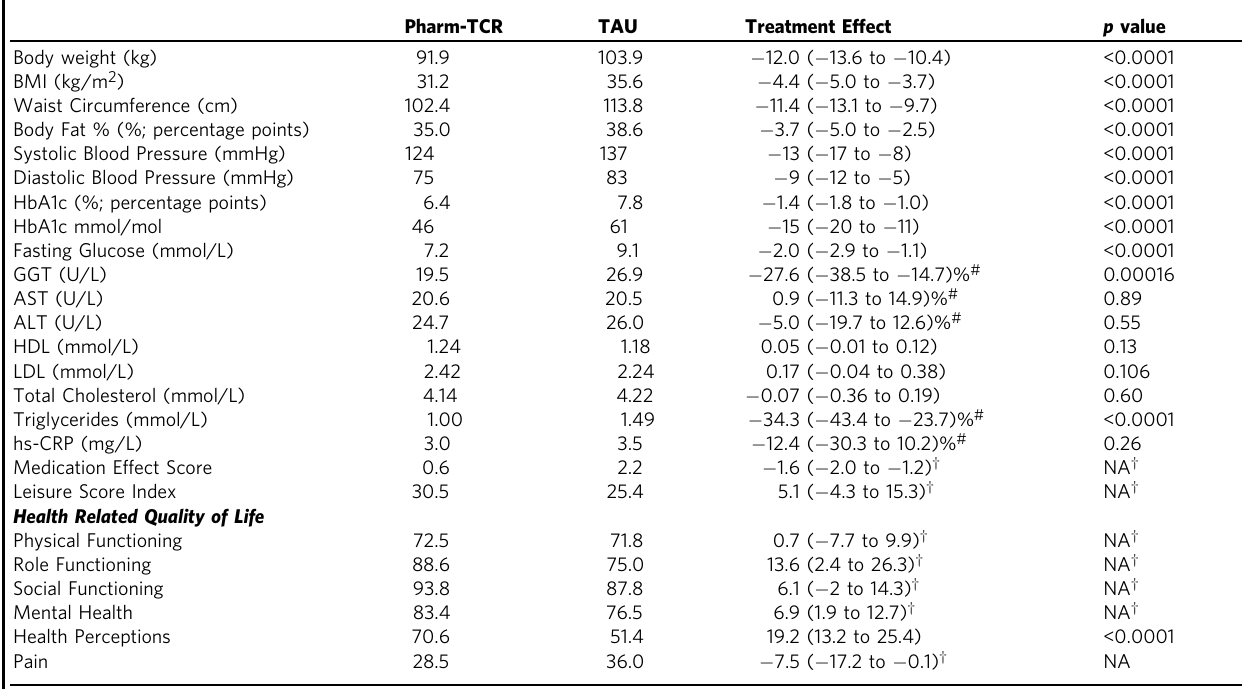
Table 2 Secondary outcomes measured at 12-week